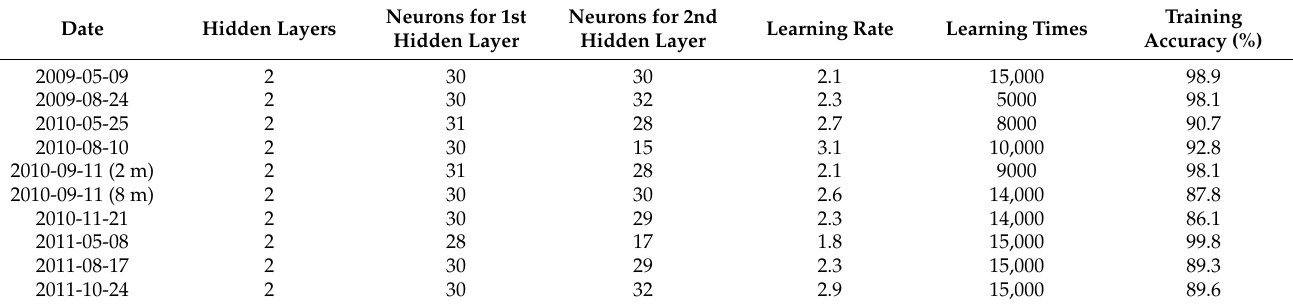
Table 3. Summary of genetic adaptive neural network (GANN) framework parameters and training results of satellite images.